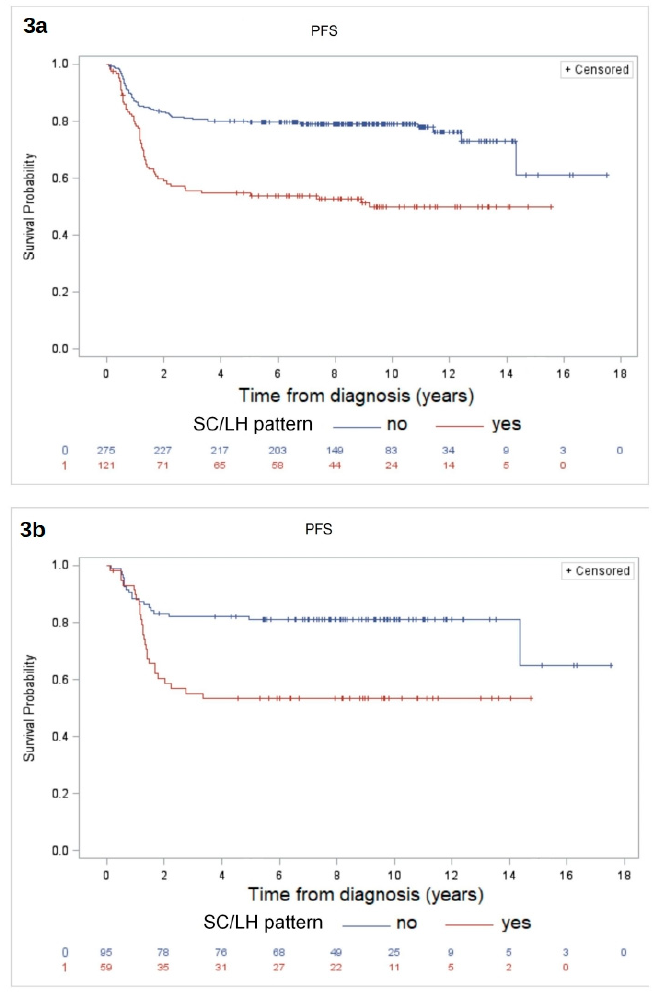
Figure 3. The 10-year PFS for the full cohort of 420 patients was 50% (SE ± 5%) in the SC/LH subtype group and 78% (SE ± 2%) in the non-SC / LH group, p < 0.0001, ( a ); the 10-year PFS in the subset of group and 78% (SE ± 2%) in the non-SC/LH group, p < 0.0001, ( a ); the 10-year PFS in the subset of 162 162 patients with available MDD data was 53% (SE ± 7%) in SC / LH group and 81% (SE ± 4%) in the patients with available MDD data was 53% (SE ± 7%) in SC/LH group and 81% (SE ± 4%) in the non- non-SC / LH group, p = 0.0006 ( b SC/LH group, p = 0.0006 ( b ).